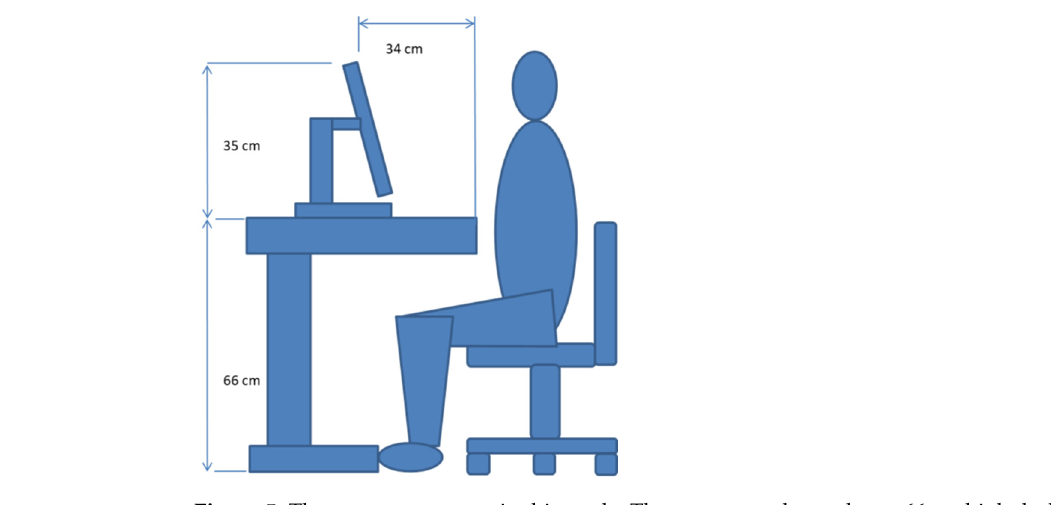
Figure 5. The apparatus set-up in this study. The screen was located on a 66 cm high desk and angled backward; the top edge of the screen was 35 cm from the desktop in the vertical direction, and the bottom edge of the screen was 34 cm from the desk edge near the participant. Participants sat on a chair and adjusted the seat height until they felt comfortable operating the apparatus.